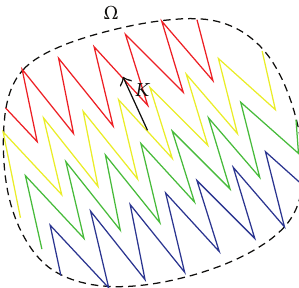
Figure 13: A function that is 𝐾 monotone, but not Normal monotone.